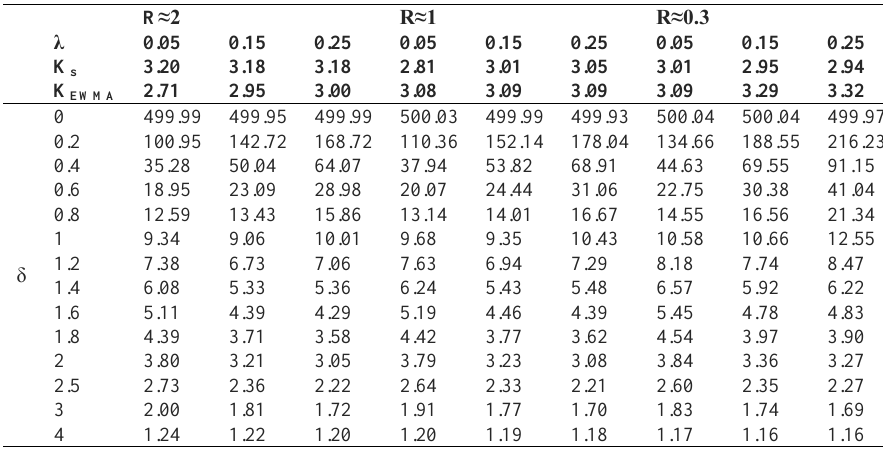
Table 5. ARL results for steady-state one-sided